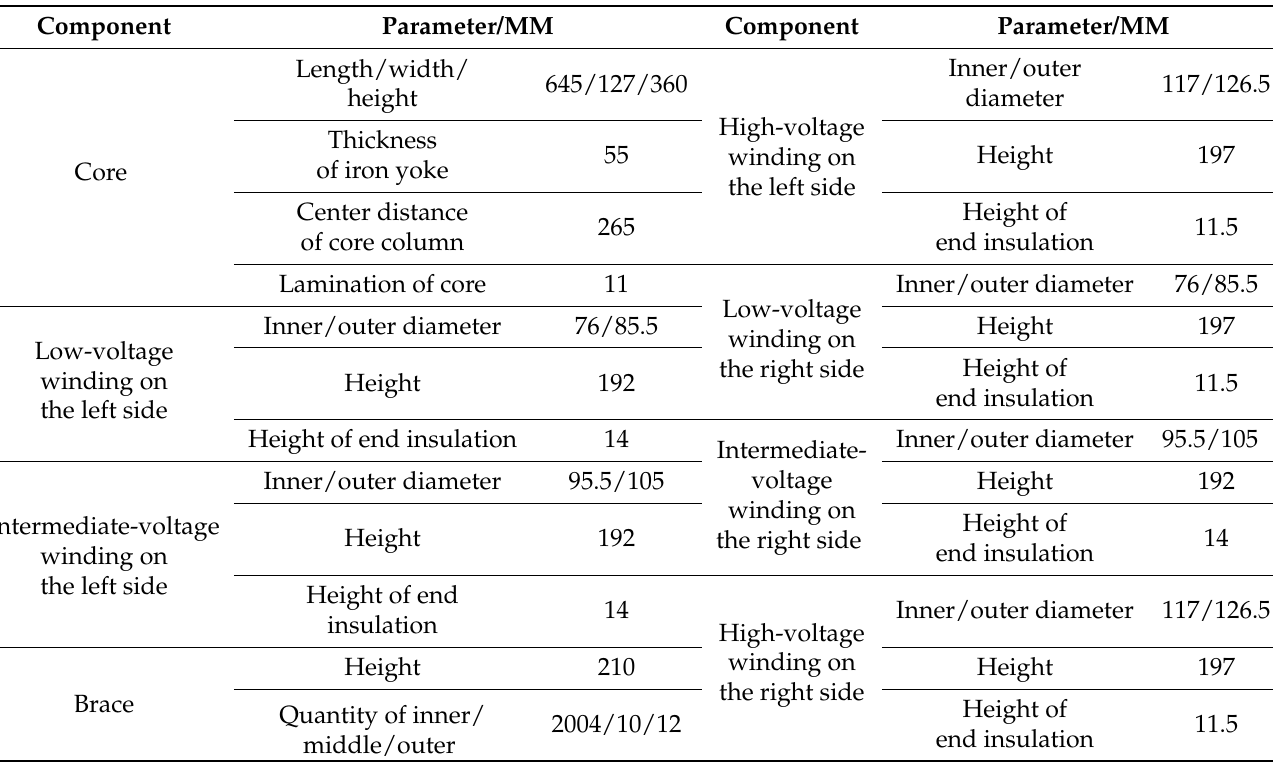
Table 2. Structural parameters of converter transformer